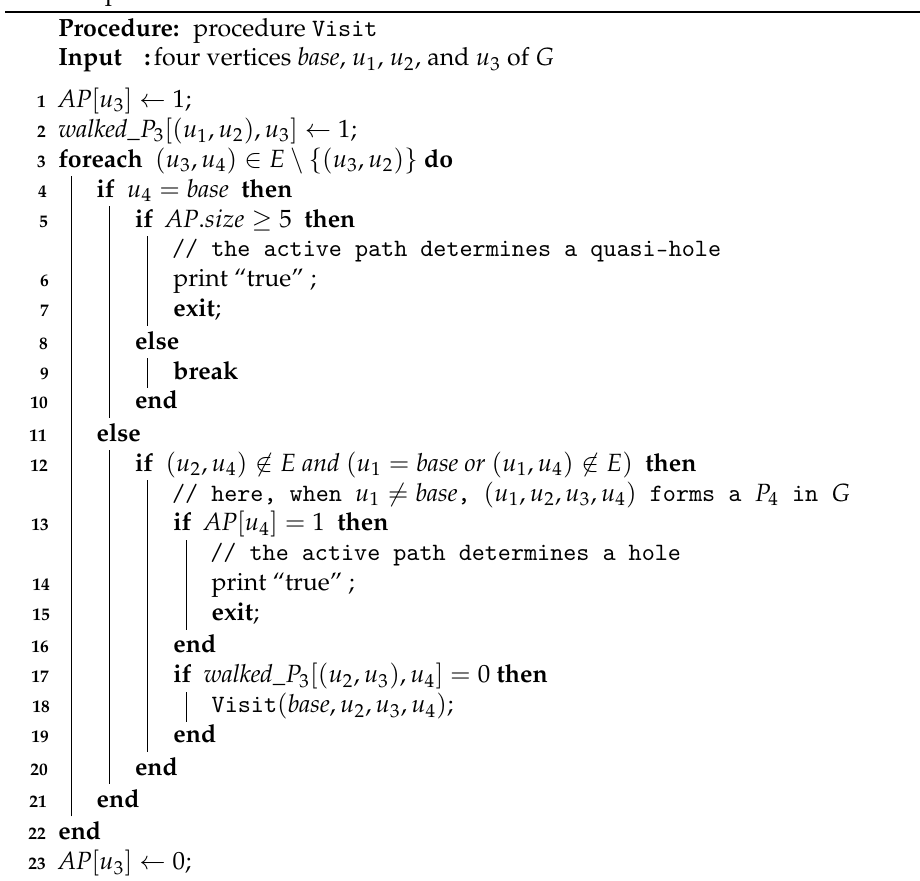
Algorithm 2: A recursive procedure used by QuasiHoleDetection to perform an adapted